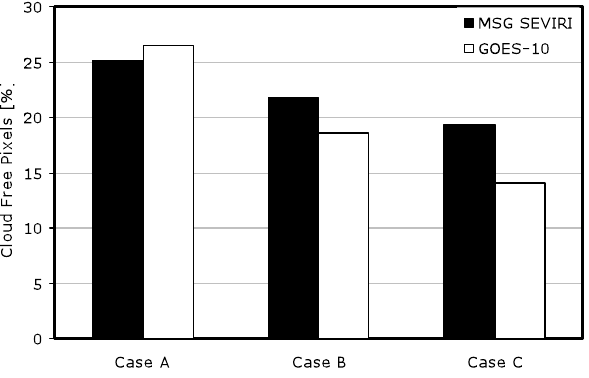
Fig. 4. Percentage of cloud free pixels for Case A, B, and C. Figure 4. Percentage of cloud free pixels for Case A, B, and C, for 15 min time difference.